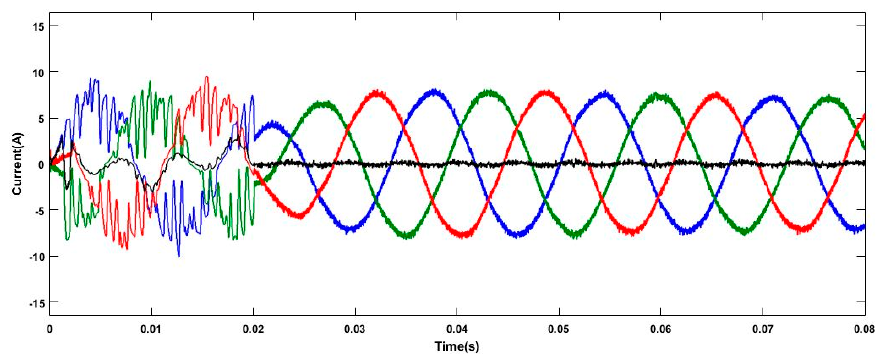
Figure 17. Compensation result with the proposed control strategy for case 3. Table 3. Compensation results for case 3.